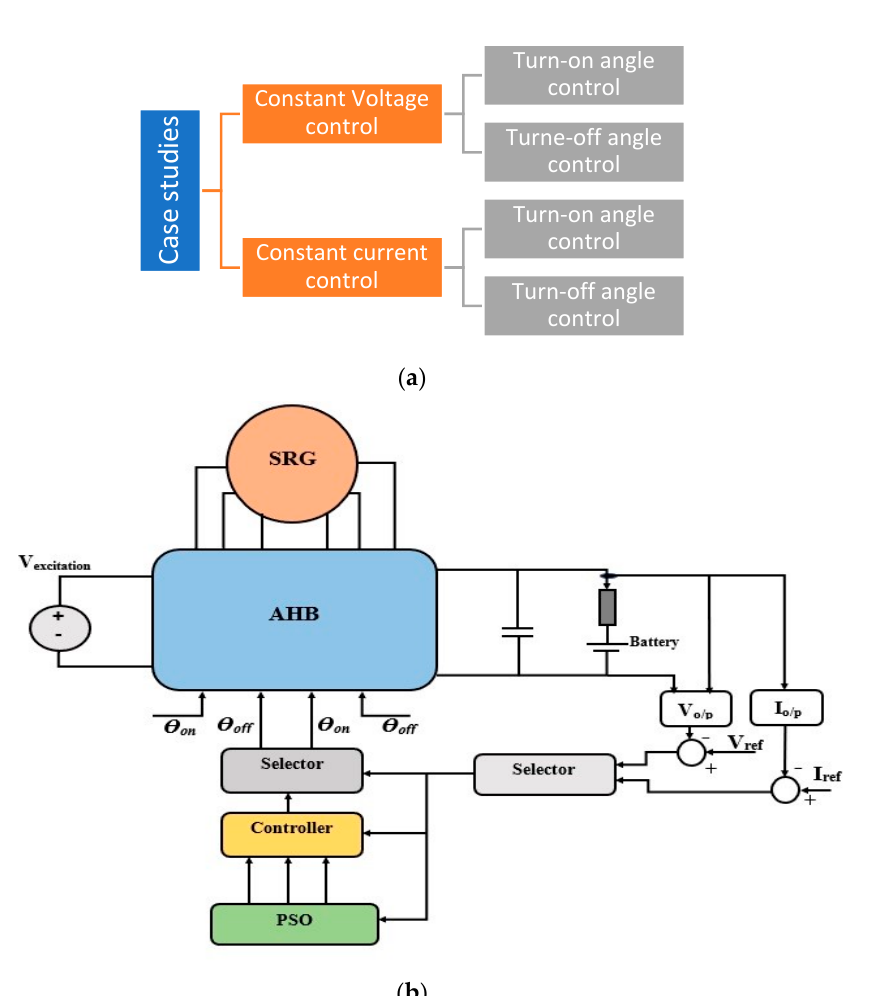
Figure 5. ( a ) Addressed case studies and ( b ) the SRG system block diagram. Table 2. Tuning of PID controller in turn